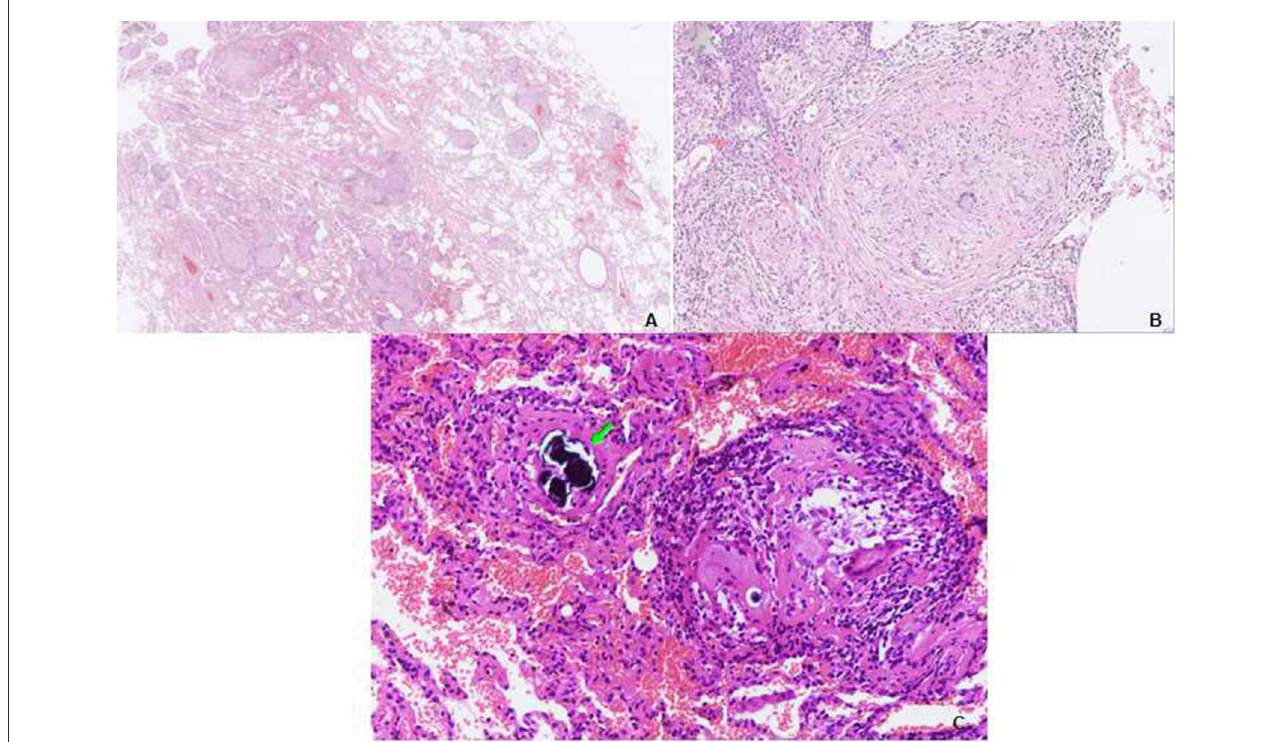
FIGURE3 Transbronchial lung biopsy (TBLB) of the right lower lobe. (A) Lower power view showing the granulomas distributed in the interstitium, not in the airspace. Some of them have a centrilobular distribution, while some are distributed in the interlobular septum. A video-assisted thoracoscopic surgery (VATS) biopsy of the right lower lobe. (B) Many well-formed non-necrotizing granulomas are composed of epithelioid and multinucleated giant cells, with fibrous hyperplasia (hematoxylin and eosin [HE], × 40). (C) Multiple sarcoid-like granulomas composed of clustered epithelioid and multinucleated giant cells, a Schaumann body is observed (arrows) (HE, ×